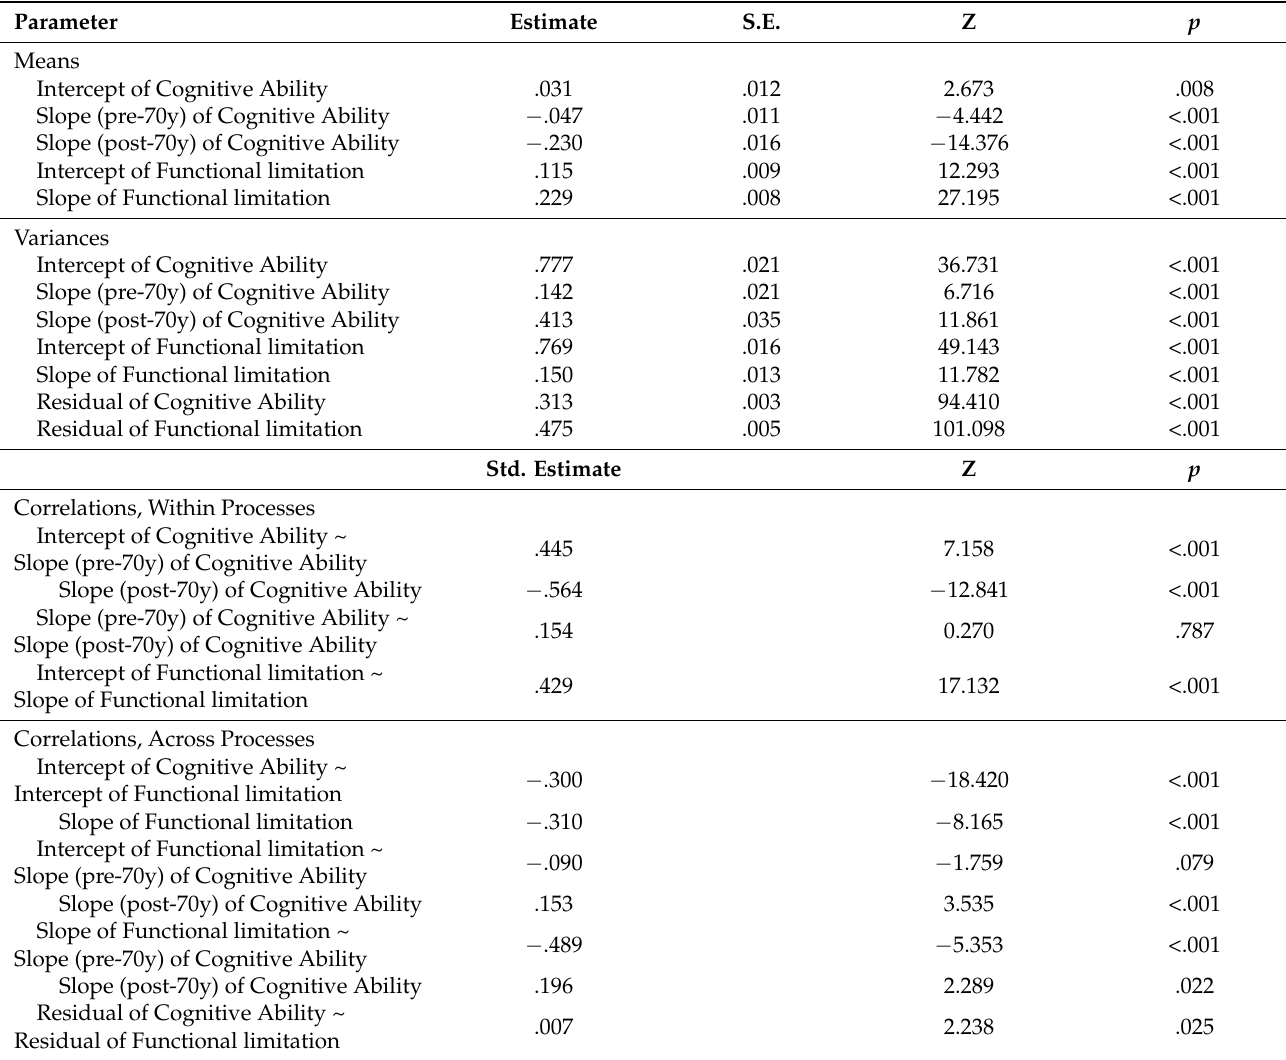
Table 3. Parameter estimates for the bivariate trajectories of cognitive ability and functional